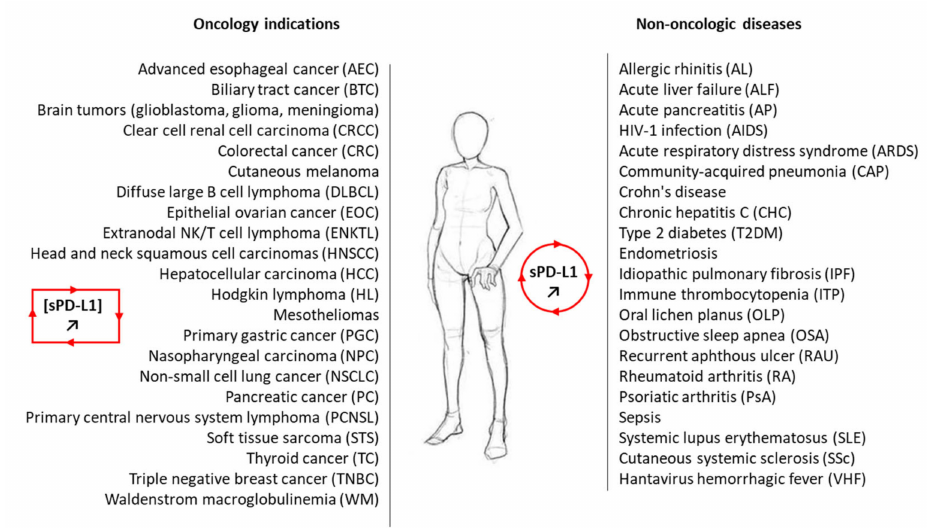
Figure 2. A non-exhaustive list of malignant and non-malignant diseases for which sPD-L1 has been measured in the plasma of patients. In most cases, the level of circulating sPD-L1 was found to be enhanced in the plasma of patients with the indicated pathology compared to healthy control (see Table 1. For the oncology indications, the presence of sPD-L1 and its significance are discussed in